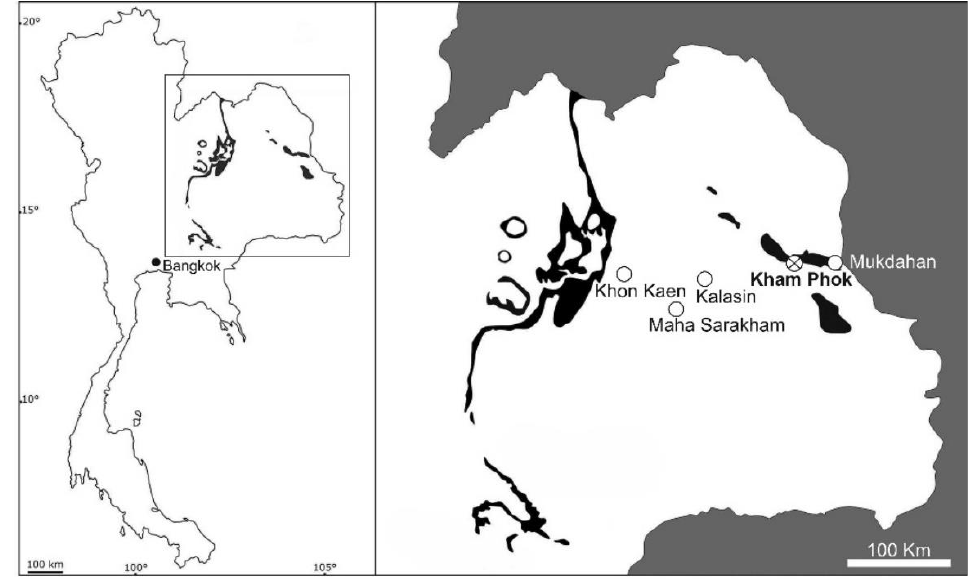
Figure 1. Location of the Kham Phok site; black color represents the distribution of the Phu Kradung Formation on the Khorat Plateau.